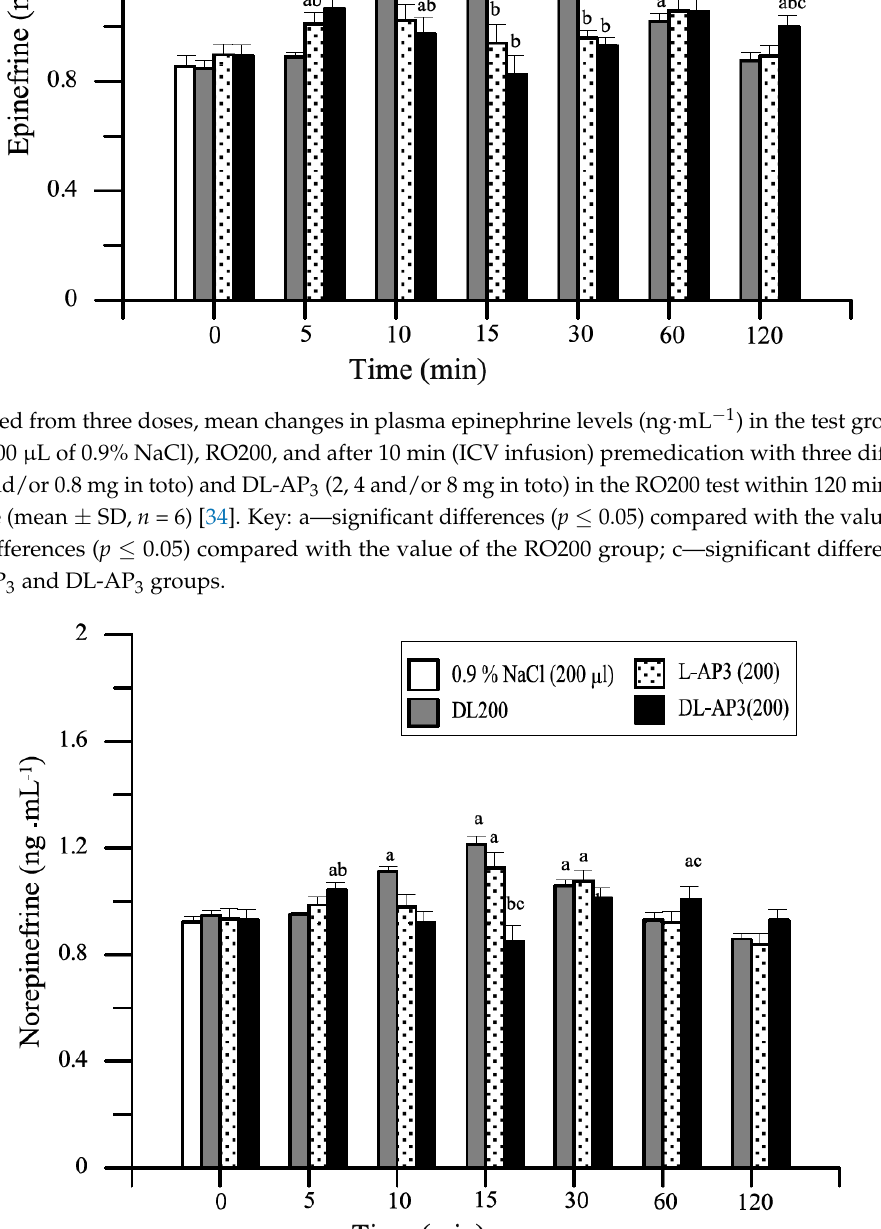
Figure 15. Summed from three doses, mean changes in plasma norepinephrine levels (ng·mL − 1 ) in the test groups of animals. Control group (200 µL of 0.9% NaCl), RO200, and after 10 min (ICV infusion) premedication with three different doses of L-AP 3 (0.2, 0.4, and/or 0.8 mg in toto) and DL-AP 3 (2, 4, and/or 8 mg in toto) in the RO200 test within 120 min of completing the RO procedure (mean ± SD, n = 6 ) [34]. Key: a—significant differences ( p ≤ 0.05) compared with the value of 0.9% NaCl; b—significant differences ( p ≤ 0.05) compared with the value of the RO200 group; c—significant differences ( p ≤ 0.05) between the L-AP 3 and DL-AP 3 group.